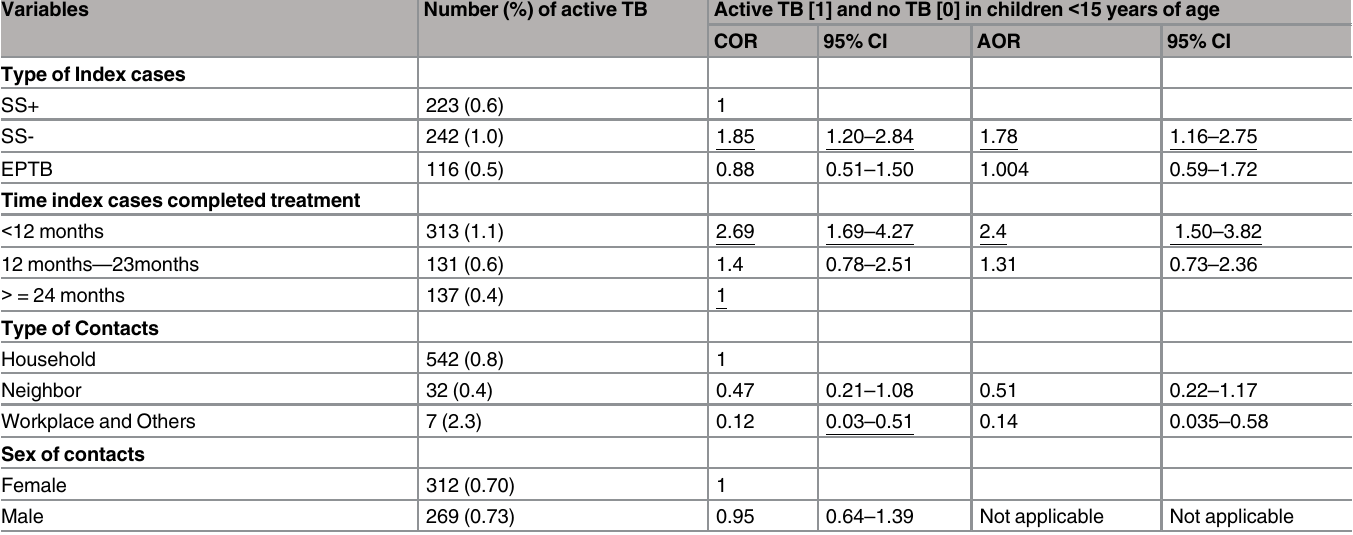
Table 3. Determinants of active TB in children < 15 years through retrospective contact screening, June-October 2014, Ethiopia.